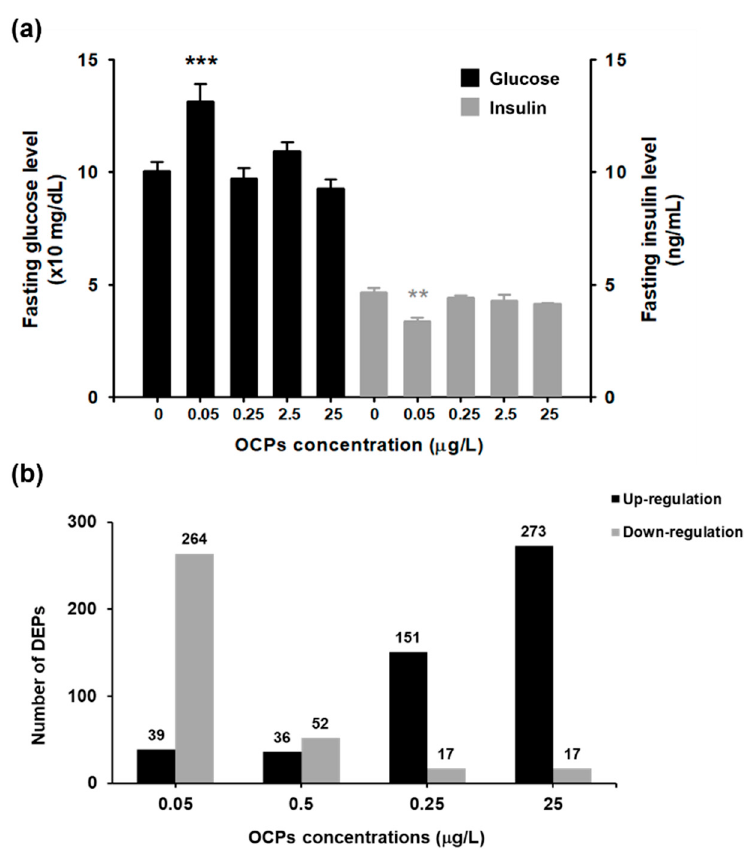
Figure 1. Blood analysis and protein identification in zebrafish exposed to organochlorine pesticide mixtures at concentrations of 0.05, 0.25, 2.5 and 25 µ g/L: ( a ) The fasting glucose level ( × 10 mg/dL, black) and fasting insulin level (ng/mL, gray) were described with the color difference and designed by *** p < 0.001 and ** p < 0.01; ( b ) The number of up- (black) and down-regulated (gray) proteins was shown.